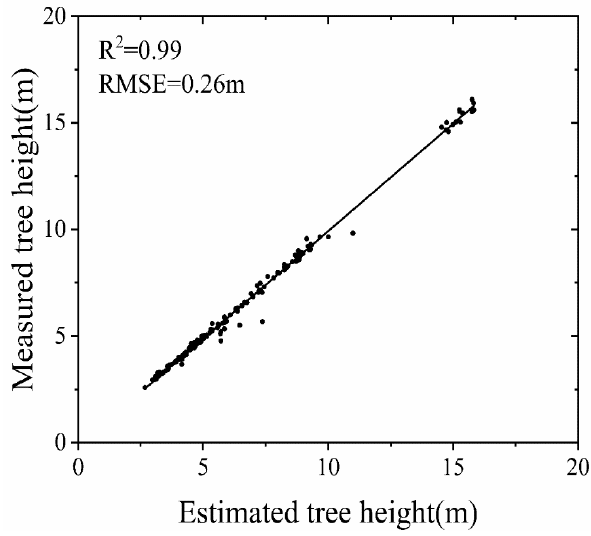
Figure 9. Correlation between the tree height after time difference correction and the tree height derived from UAV stereo images.